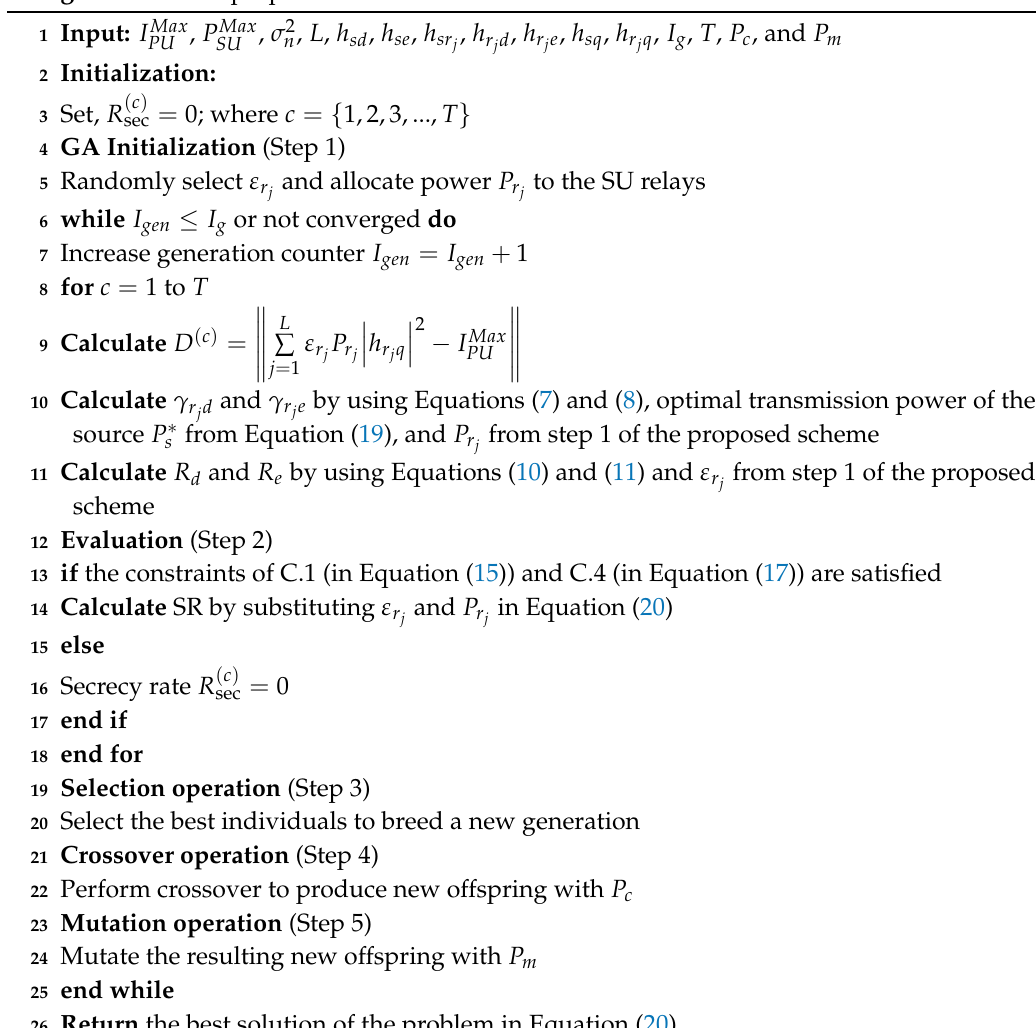
Algorithm 2: The proposed GA-based MRS and PA scheme for SR